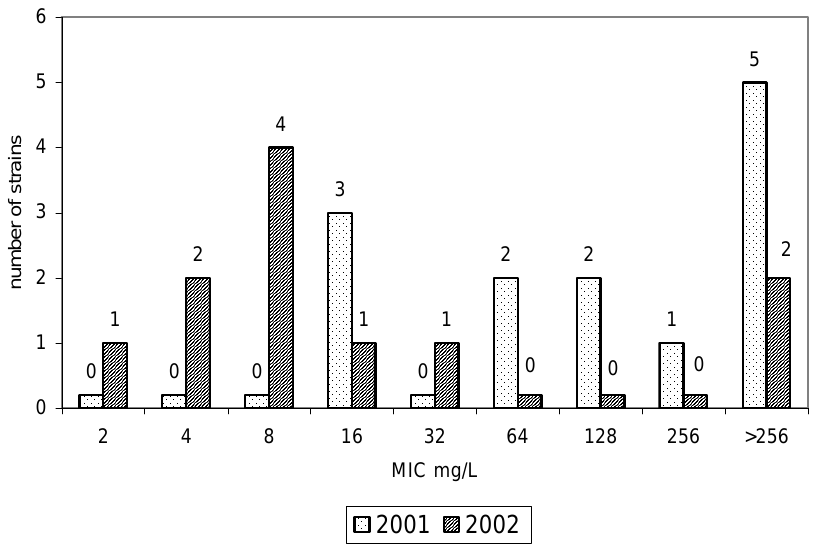
Figure 11. The teicoplanin MICs of the vanA positive E. durans strains isolated in 2001 and 2002